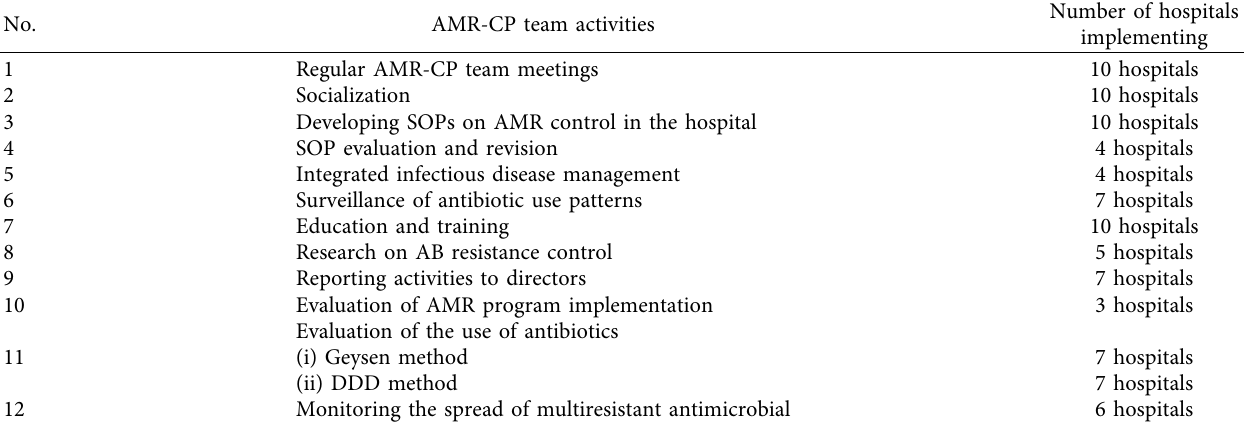
Table 2: AMR-CP team activities in 10 hospitals in Indonesia, in